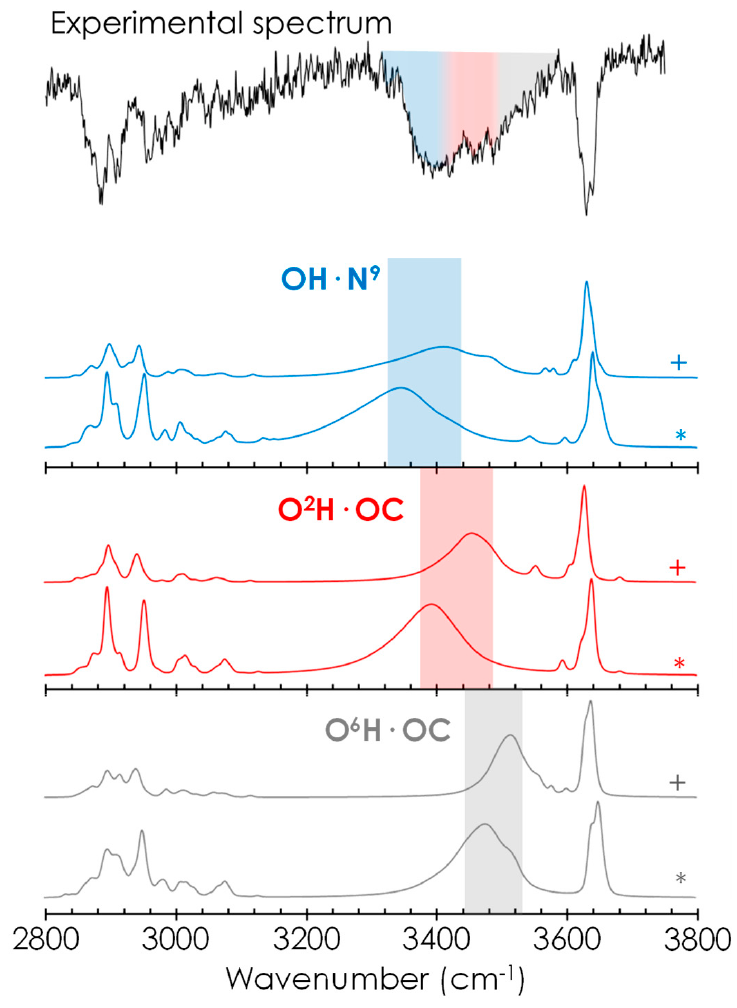
Figure 4. Above the experimental spectrum, below the computation average simulation for the three groups of families with absorption in the experimental observed range. The theoretical simulation at M06-2X/6-311++G(d,p) level are labelled with (+) and the theoretical simulation at B3LYP-GD3BJ/def2TZVP level are labelled with (*).